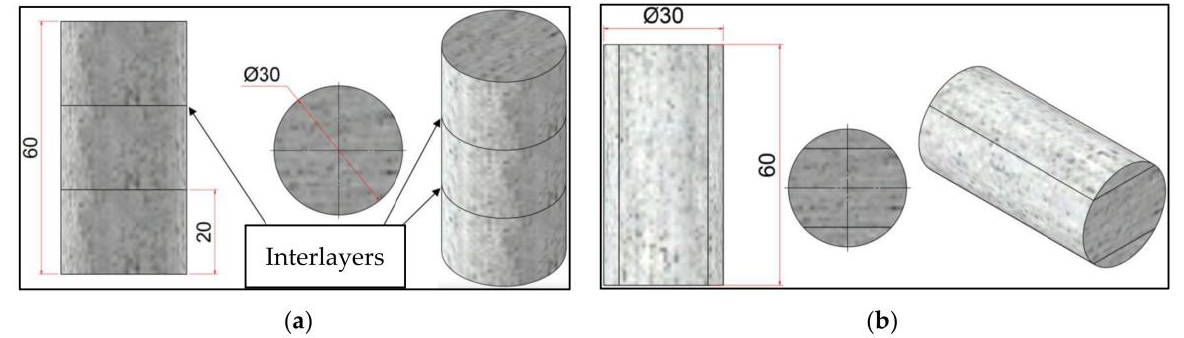
Figure 3. ( a ) OI test specimen with interlayers horizontal; ( b ) OIII test specimen with interlayers vertical. Units in mm.